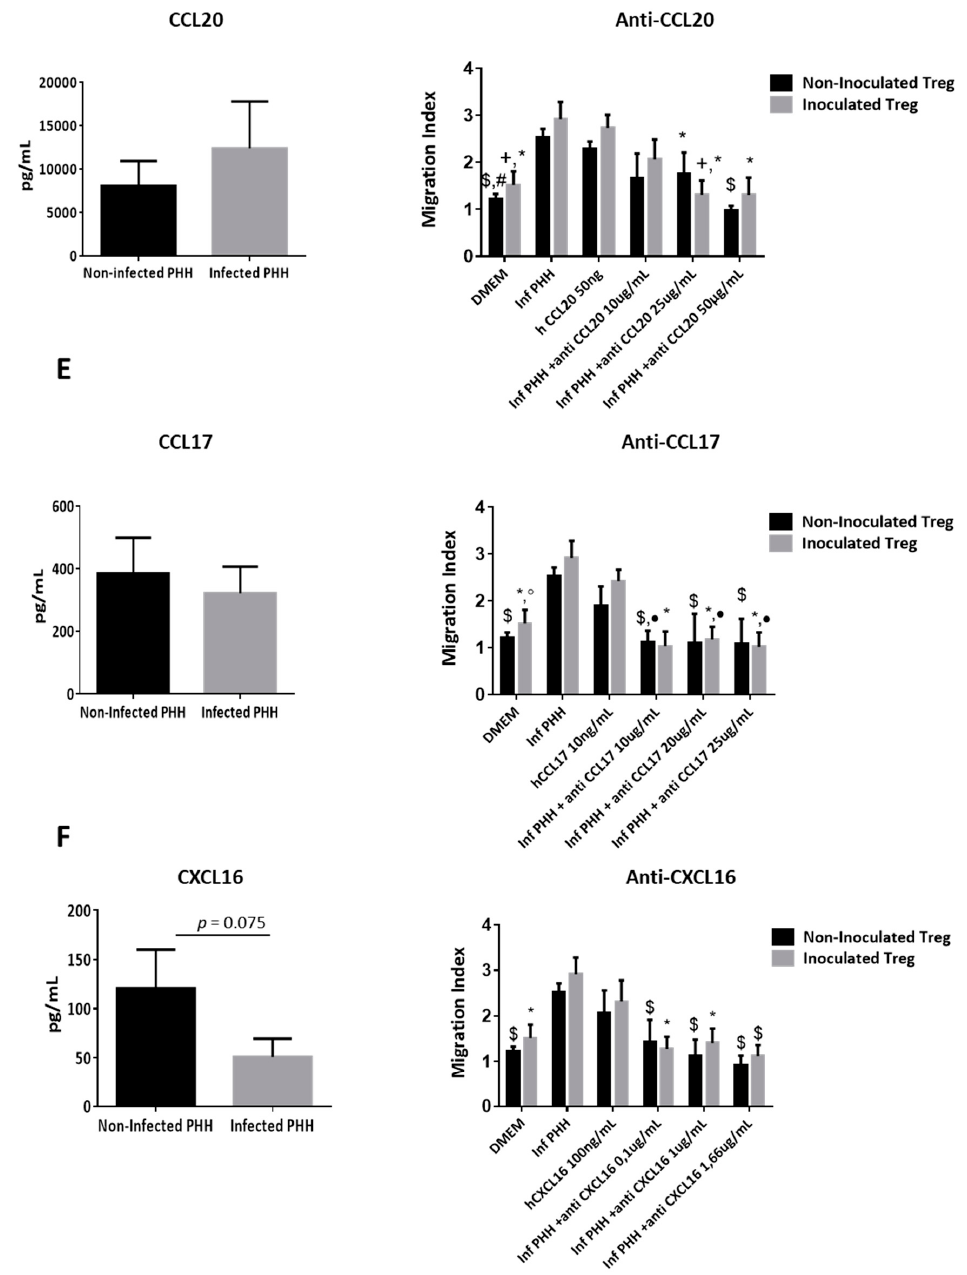
Figure 6. Tregs are recruited by infected primary human hepatocytes supernatants. Tregs recruitment by primary human hepatocytes (PHH) was evaluated by a Boyden chamber assay. In vitro infected PHHs recruit more natural Tregs than non-infected PHHs ( A ). Results are expressed as mean values of quintuplicate of six independent experiments and presented in index of migration of Tregs ± SEM bars. qPCR analyses show an increase of the expression of several chemokines associated with Treg recruitment such as CCL20, CCL17 or CXCL16 by PHH ( B ). Results are presented as means of five independent experiments on infected PHH (light grey bars) versus non-infected PHH (dark bars). HCV inoculation also increases the expression of corresponding chemokines receptors by isolated Tregs at 3 h p.i and 24 h p.i ( C ). All gene expressions are normalized by using GADPH, beta-actin, 18s and HRPT mRNA as housekeeping-genes and the results are expressed in fold change (2 – ∆∆ Ct ) ± SEM bars of